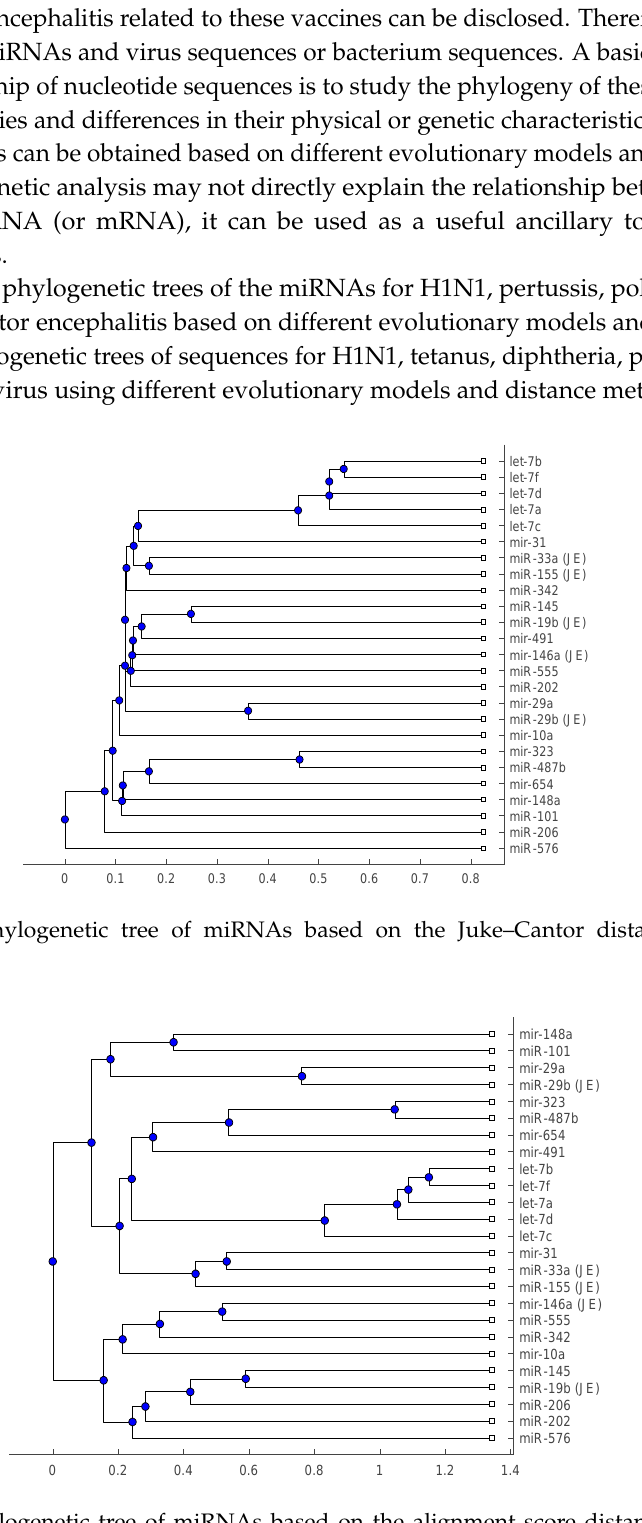
Figure 2. The phylogenetic tree of miRNAs based on the alignment score distance and average linkage function.